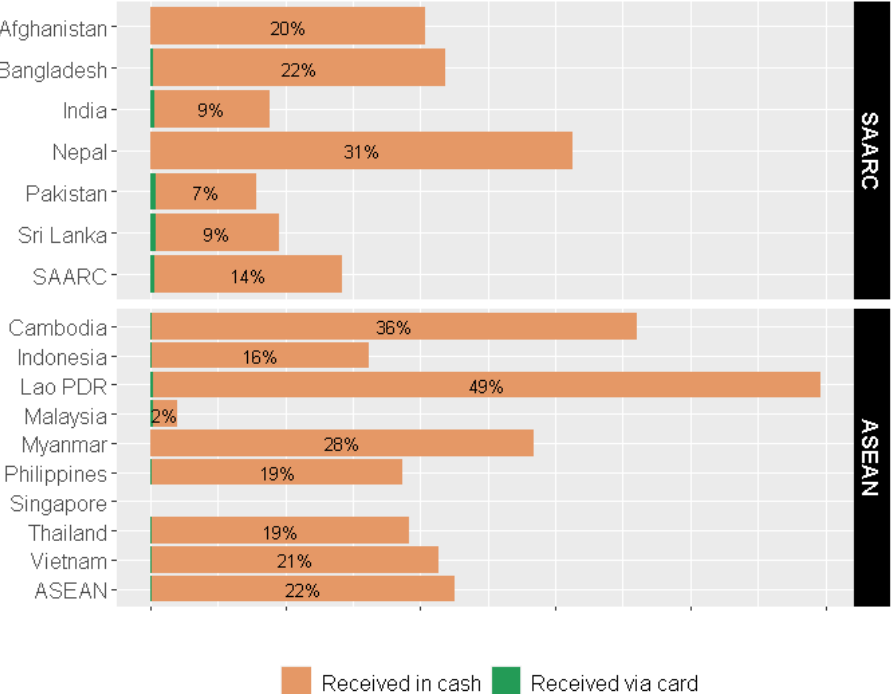
Figure 14. Percentage of participants who received money from agricultural activities in cash, or via cards.